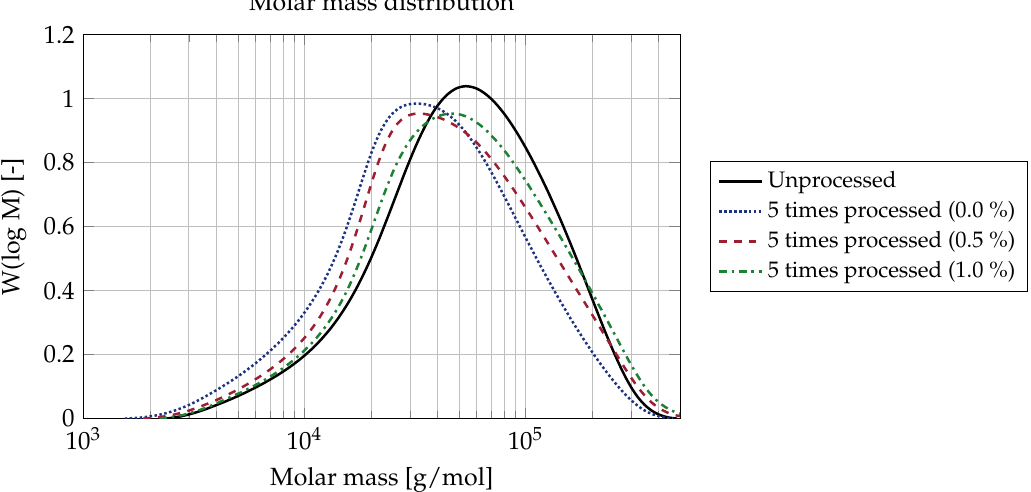
Figure 5. Molar mass Distribution for the virgin plastic and the samples subjected to five-fold processing.